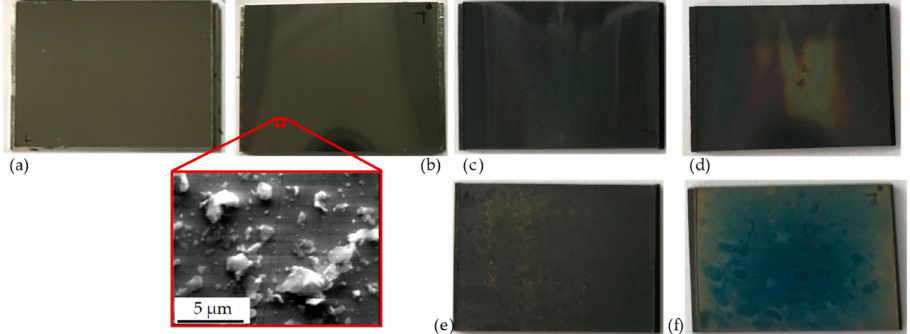
Figure 2. Substrate before coating in DRESDEN-TUBE ( a ), before ( b ) and after thermal annealing in the DRESDEN-TANK for 100 h at 750 ◦ C, 6 MPa helium; with particles: ( c ) Alloy 800H, ( d ) Inconel 617; without particles: ( e ) Alloy 800H, ( f ) Inconel 617.